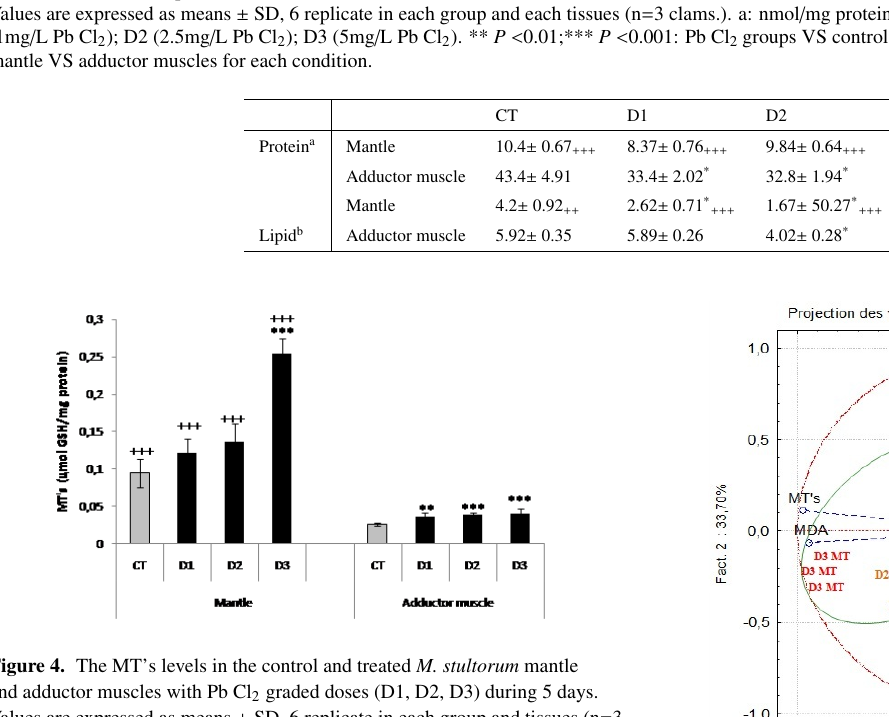
Table 1. Protein and Lipid contents in the control and treated M. stultorun mantle and adductor muscle with PbCl 2 graded Doses (D1. D2. D3) during 5 days. Values are expressed as means ± SD, 6 replicate in each group and each tissues (n = 3 clams.). a: nmol / mg protein. b: mg / mg protein. Pb Cl 2 graded doses: D1